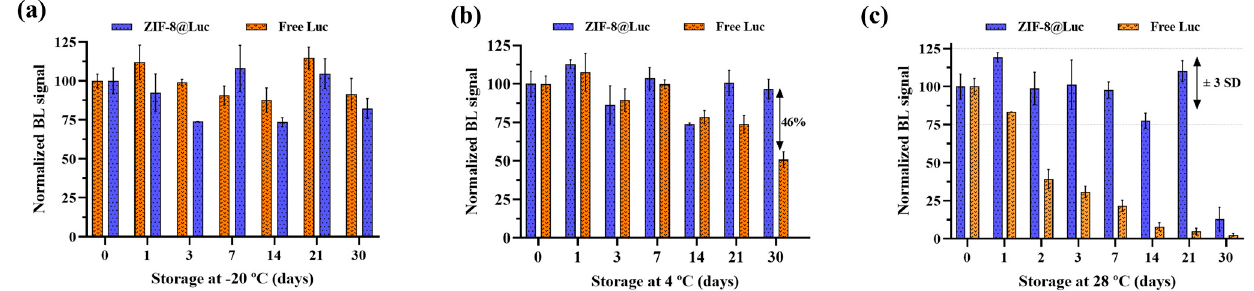
Figure 5. Stability studies of the ZIF − 8@Luc paper sensor after storage at − 20 °C ( a ), + 4 °C ( b ) and + +28 ◦ C ( c 28 °C ( c ).